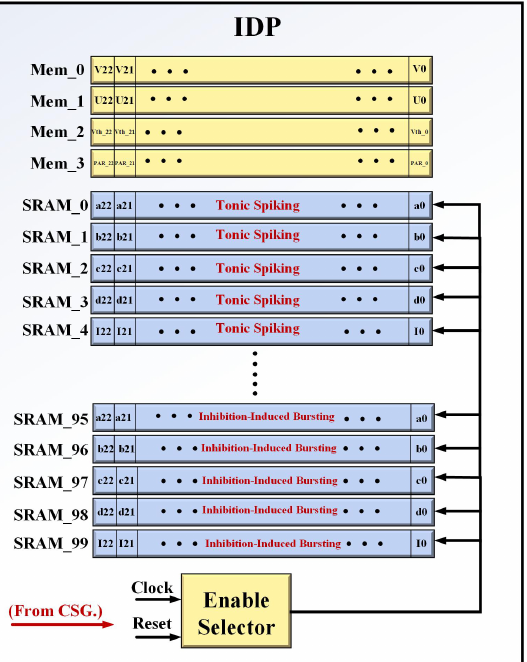
Figure 5. Structure of the IDP. Each memory stores the parameters for reproducing one spiking